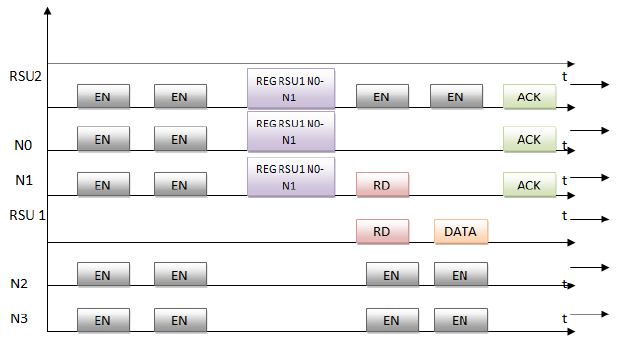
Figure 3. Multichannel MAC Model.